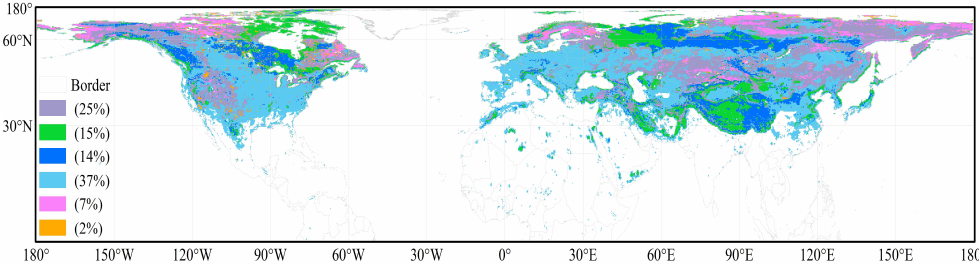
Figure A4. The analysis results of the variation trends for SCD and the annual maximum SD over the Northern Hemisphere during 1992 – 2016. Grey indicates that the areas are undergoing a significant increase (or decrease) for SCD (or annual maximum SD) and non-significant change for annual maximum SD (or SCD); green indicates that the areas are undergoing a significant decrease for annual maximum SD and SCD; blue indicate that the areas are undergoing a significant decrease for annual maximum SD and significant increase for SCD; cyan indicates that the areas are undergoing a non-significant change for annual maximum SD and SCD; violet indicates that the areas are undergoing a significant increase for annual average SD and a significant decrease for SCD; orange indicates that the areas are undergoing a significant increase for annual maximum SD and SCD. The significant increase (or decrease) here means that this variation trend passes the 95% confidence level test. The numbers in brackets represent the proportion of the total snow cover area.